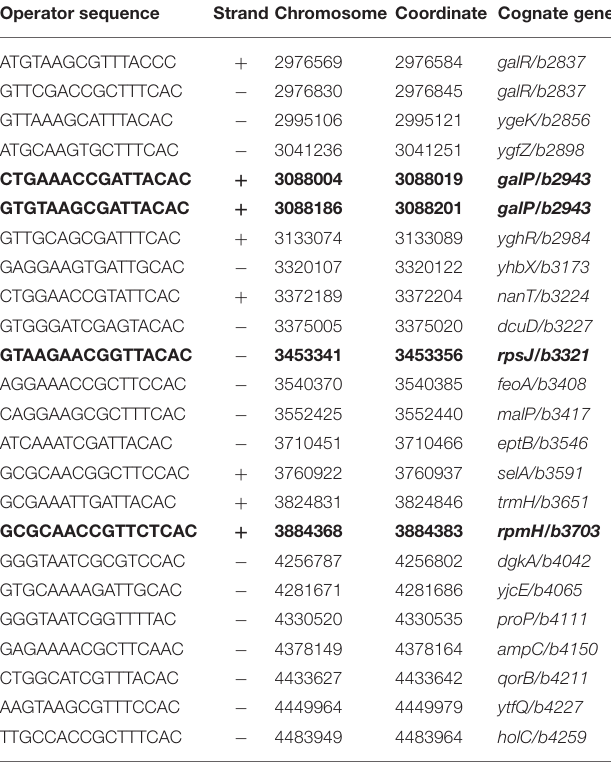
TABLE 4 | Gene Regulatory Sites discovered by sequence analysis. Operator sequence Strand Chromosome Coordinate Cognate